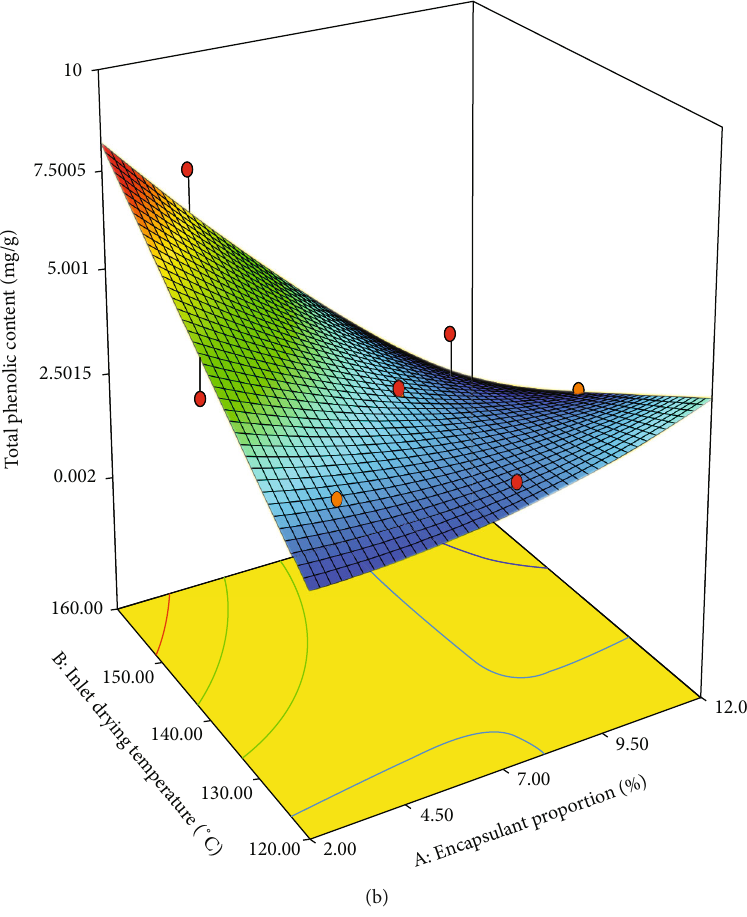
Figure 1: E ff ect of IDT and encapsulant proportion on EE (a) and total phenol content (b) of PME Table 3: Analysis of variance (signi fi cance) of CCR design for each response.